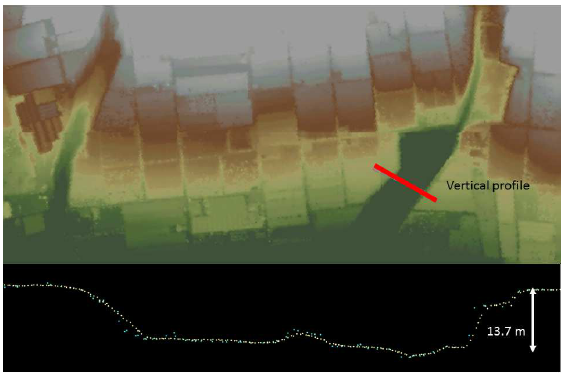
Table 1. Vertical accuracy of GMRF-computed DSMs (1 m grid spacing) depending on the tolerance parameter ( σ p ). (1) EGS =